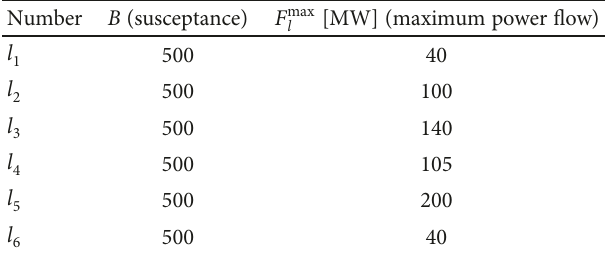
Table 7: Data for transmission lines.